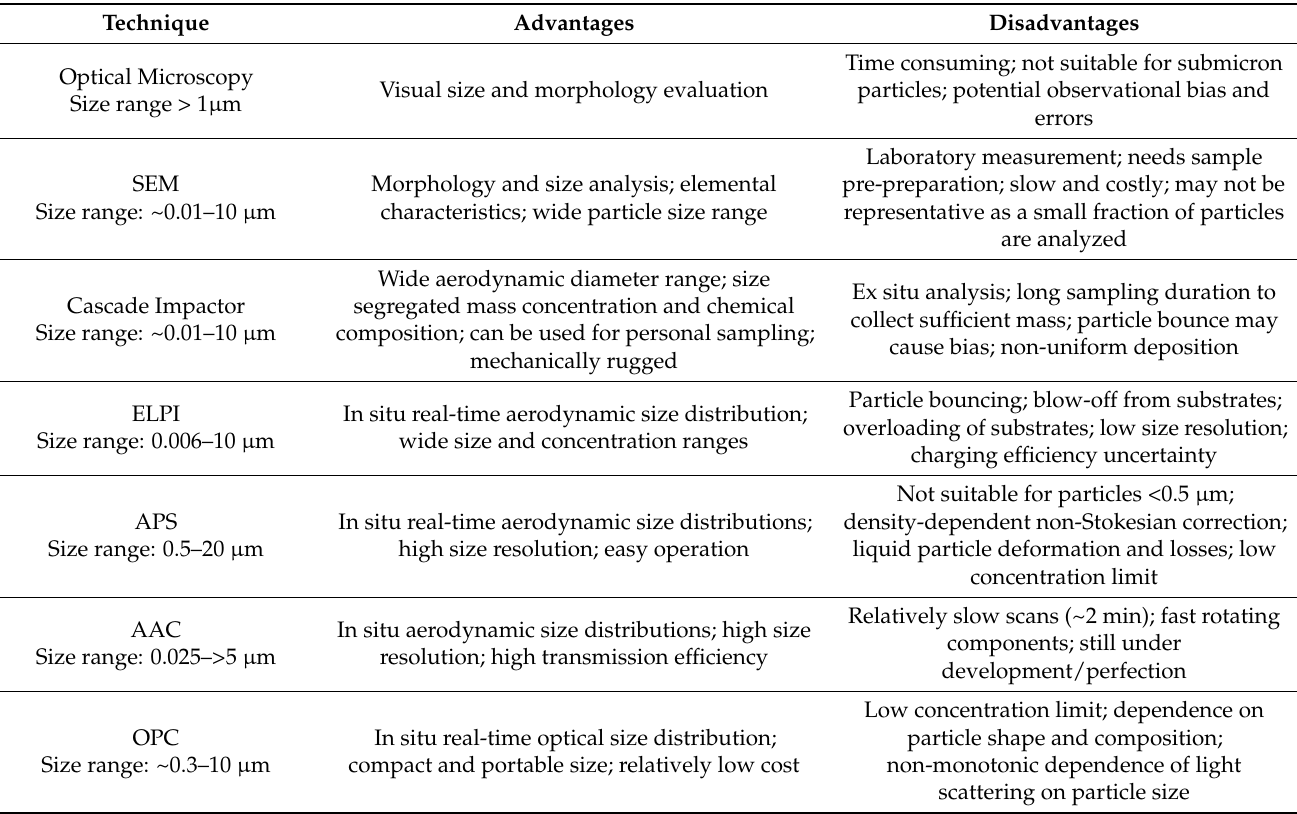
Table 2. A comparison of potential techniques that can be used for RCMD particle size characterization.